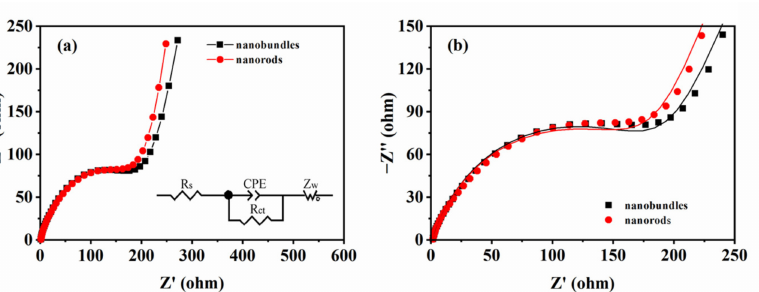
Figure 13. Nyquist plots of WO 3 nanostructures with different shapes ( a ) and corresponding enlarged fitting plots ( b ). The inset shows the equivalent electrical circuit